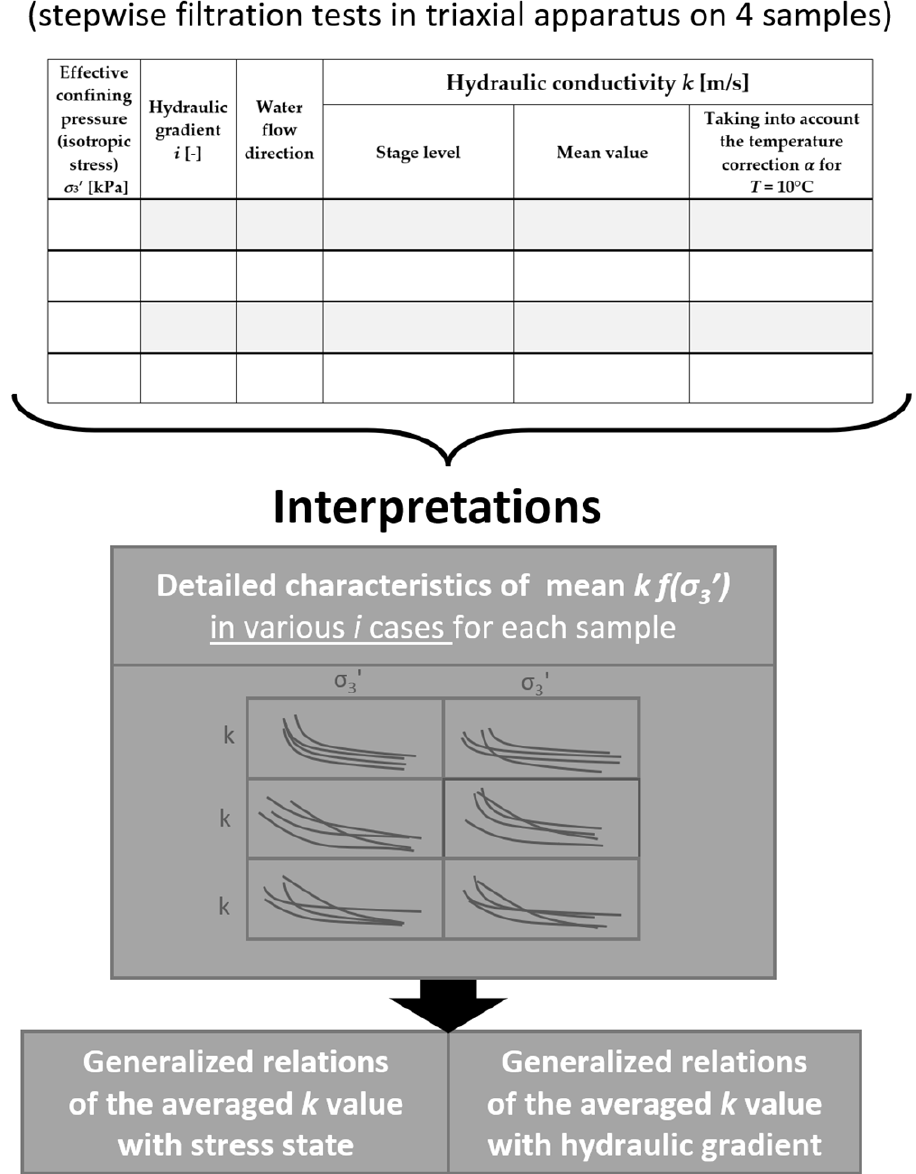
Figure 7. Workflow of results processing and interpretations stages.